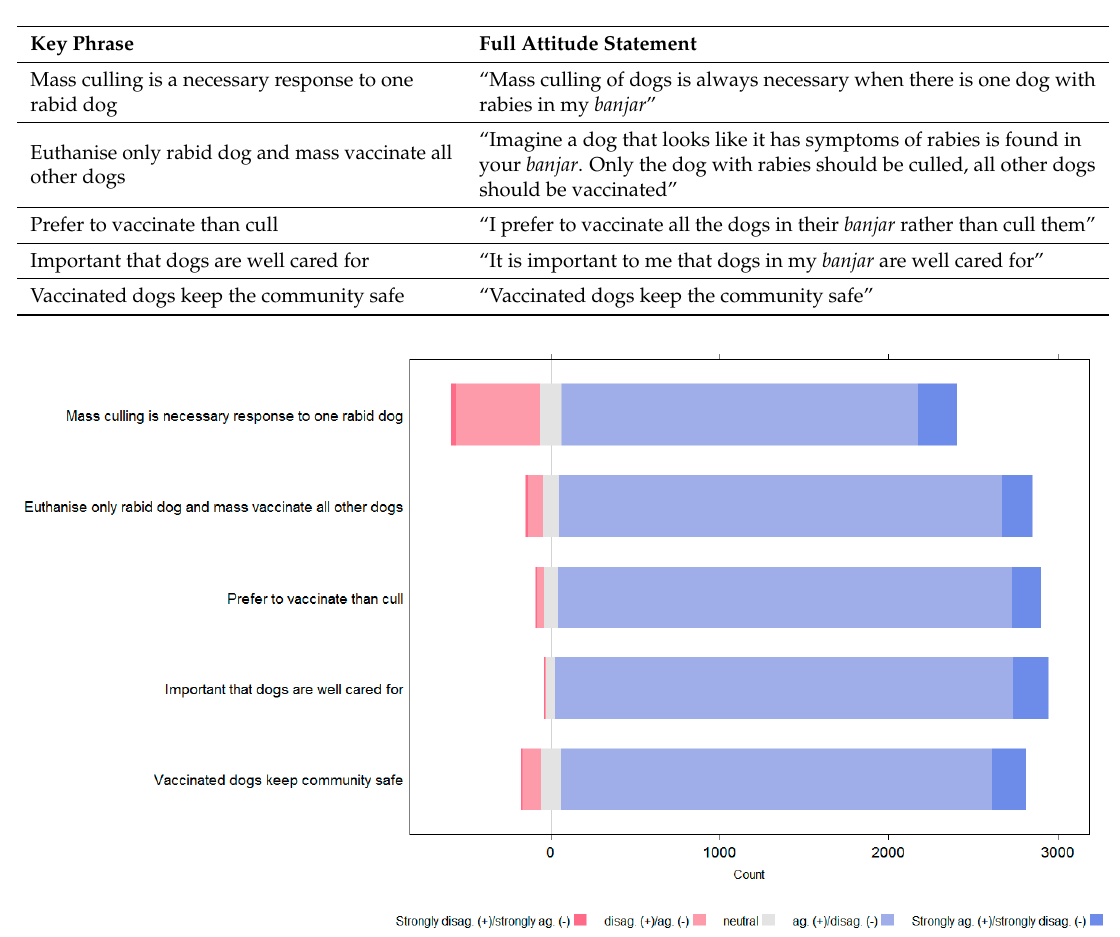
Figure 10. Level of dog owner agreement with attitude statements.